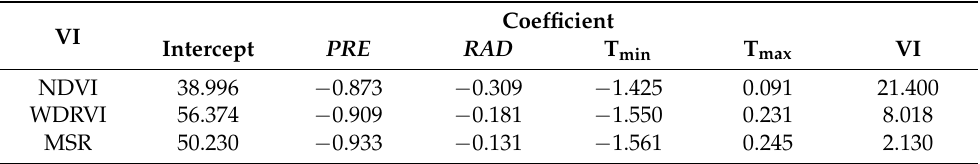
Table 6. Coefficient value of each variable in yield model by multiple linear regression (MLR). Note: PRE , rainfall; RAD , hours of